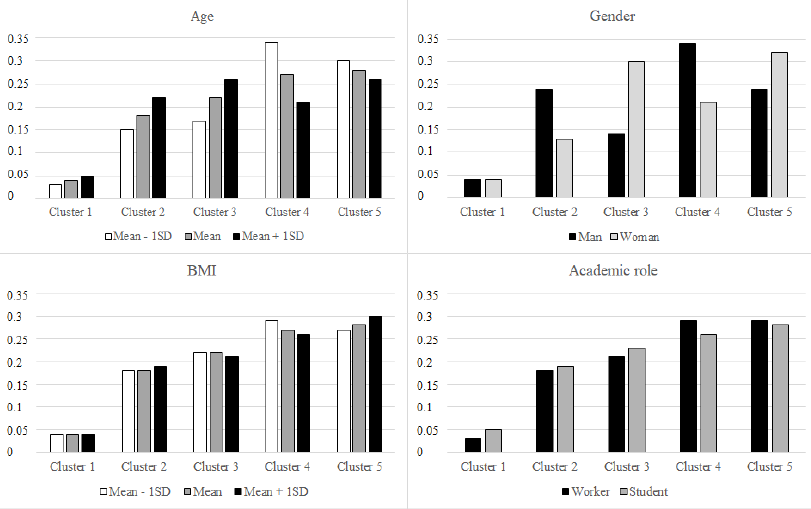
Figure 3. Distribution of the probability of belonging to each lifestyle profile as a function of sociodemographic variables and BMI.